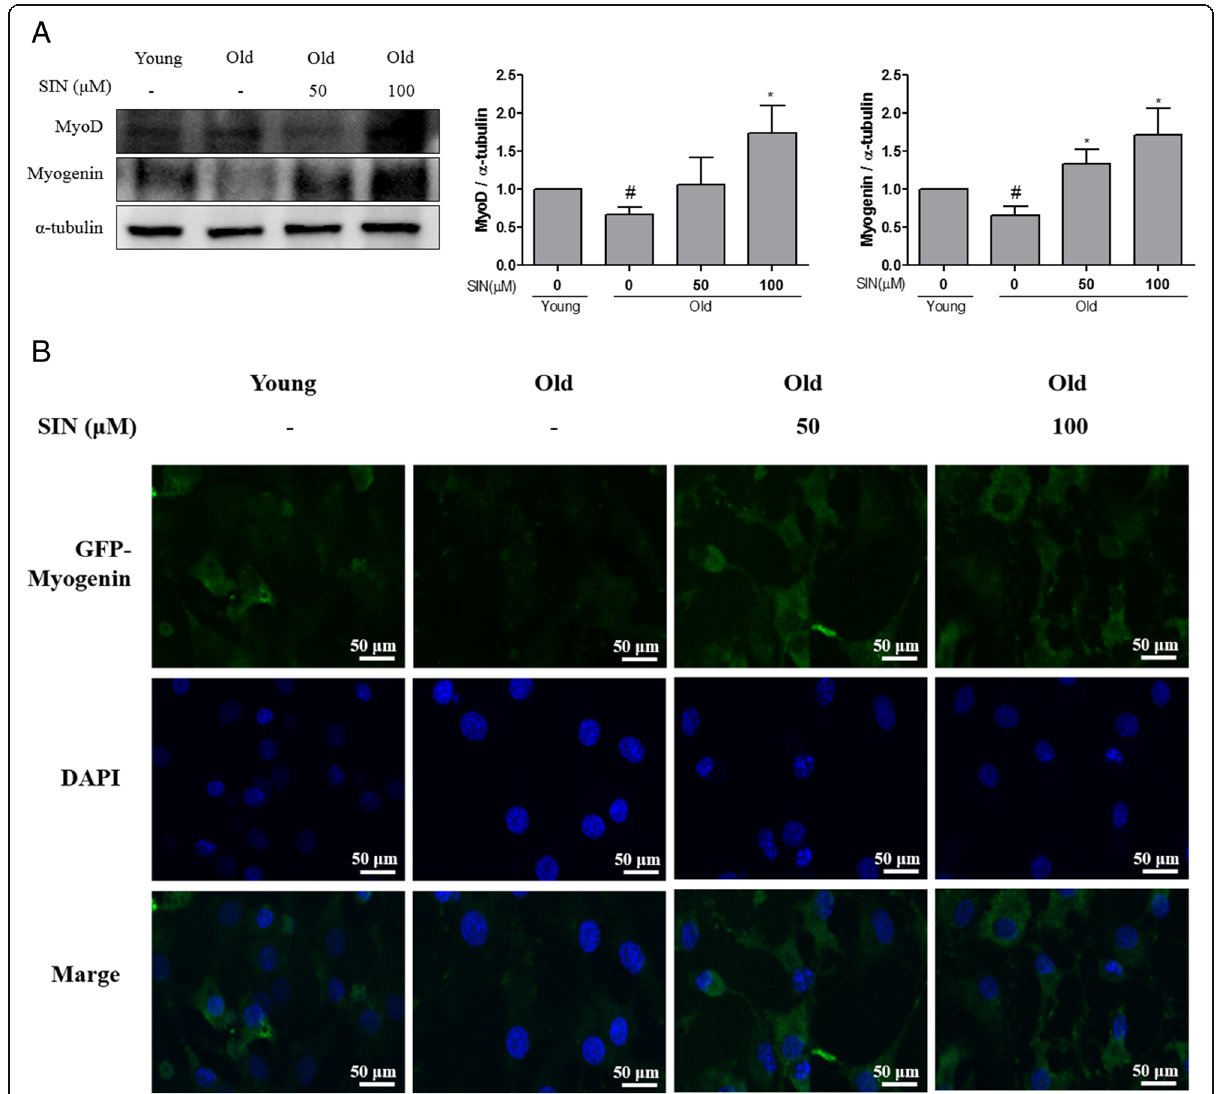
Fig. 3 Effect of sinensetin (SIN) on satellite cells of old rats in vitro. After SIN treatment with differentiation medium for 5 days, ( a ) satellite cells were harvested. MyoD and myogenin protein levels were examined by Western blotting. The level of α -tubulin was used for normalization using Image J program. Data in graphs are presented as mean ± SEM. Statically significance was determined with ANOVA followed by a Dunnett ’ s test; # p < 0.05 vs. young, * p < 0.05 vs. old with no SIN. b Differentiated satellite cells were immunohistochemically stained for myogenin in green and DAPI in blue. These images were captured with a confocal microscope